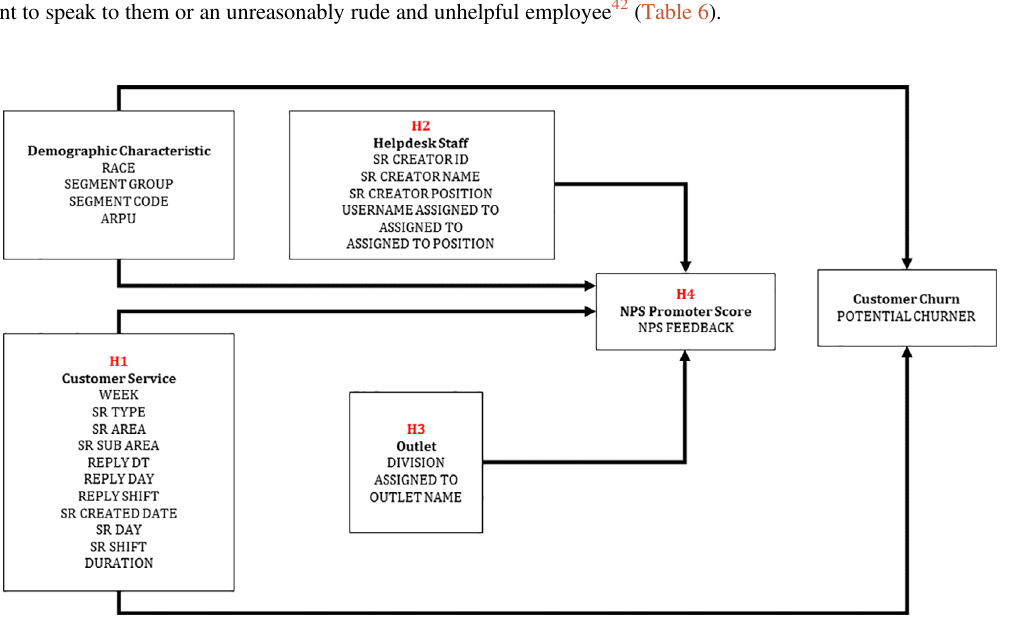
Figure 2. A conceptual model for the prediction of potential